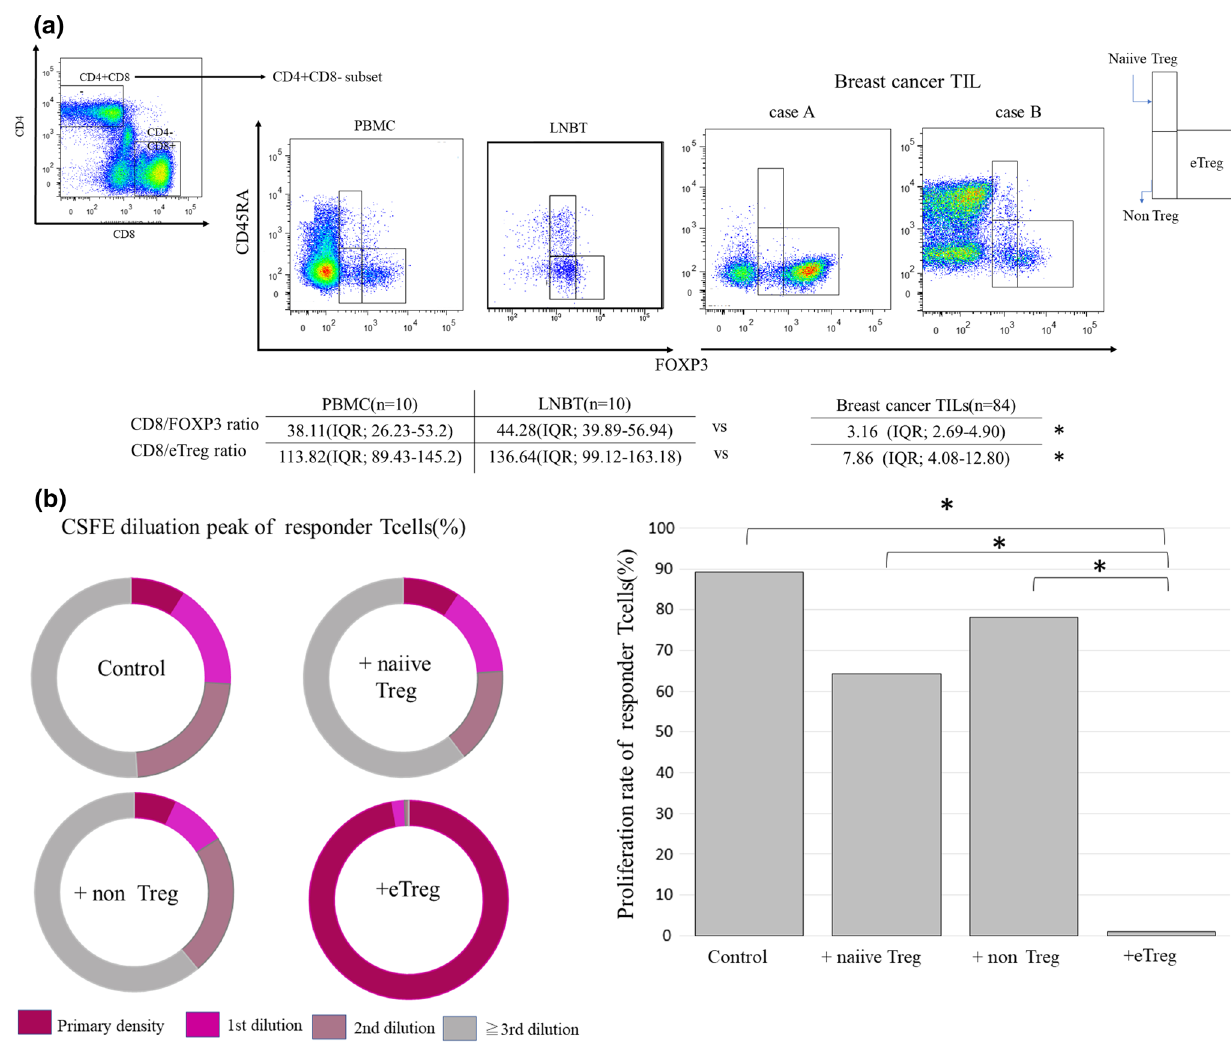
Fig. 1 Treg subpopulations as categorized using flow cytometry. a CD4 − CD8 + T cells and CD4 + CD8 − T cells were separated using flow cytometry. CD4 + CD8 − cells were further classified into naïve Treg, eTreg, and non-Treg cells using FOXP3 and CD45RA staining. The TIL sub- populations in LPBC, LNBT, and breast cancer TILs are shown in the center. CD8/FOXP3 and CD8/eTreg ratios were calculated using the pro- portions of these subpopulations. The values of PBMC (n = 10) and LNBT (n = 10) are shown as the median value (IQR). Breast cancer TILs (Cases A and B) are shown as representative samples, and the CD8/FOXP3 and CD8/eTreg ratios are calculated. b In vitro suppression assay of breast cancer TILs. CFSE labeled CD4 + CD25- responder T cells from PBMC cultured alone (control) or with naïve Treg, eTreg, or non-Treg cells sorted from freshly extracted breast cancer TILs were cocultured at a 1:1 ratio for 5 days. The proliferation peaks of each group fol- lowing CSFE dilution were counted (right) and the proliferation rates were calculated (left). These are representative of three independent experiments; each value is the median value. c The proportion of total FOXP3 + cells and that of the Treg subpopulation of PBMC(n = 10), LNBT(n = 10), and breast cancer TILs(n = 84). % indicates the ratio of CD4 + T cells. d The proportion of total FOXP3 + cells and that of the Treg subpopulation of breast cancer TILs according to molecular subtypes. The data of Luminal (n = 44), HER2(n = 28) and TN(n = 20) subtype cases and were demonstrated by each value (dot) median(bar), and